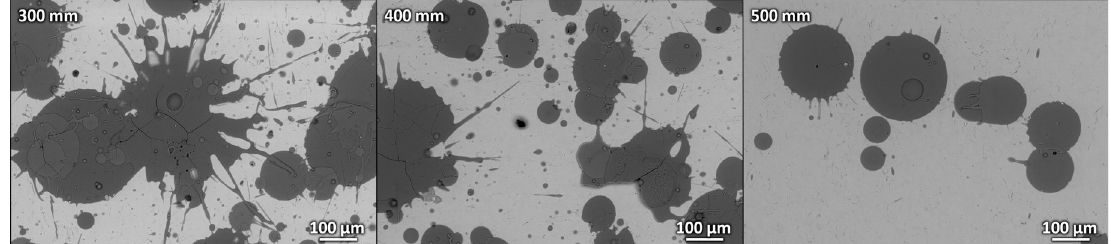
Fig 1. Selection of an appropriate stand-off distance during the HA coatings deposition process: Single splats spreading behavior upon plasma spraying at different stand-off distances 300 mm, 400 mm and 500 mm. Pictures obtained using scanning electron microscope (back-scattered